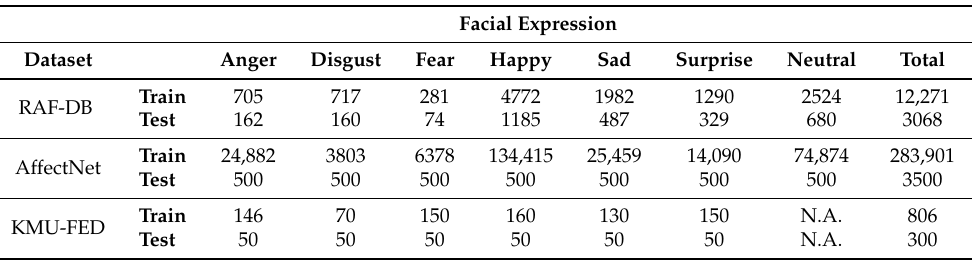
Table 3. Number of considered facial expression in RAF-DB, AffectNet and KMU-FED datasets, divided by training and